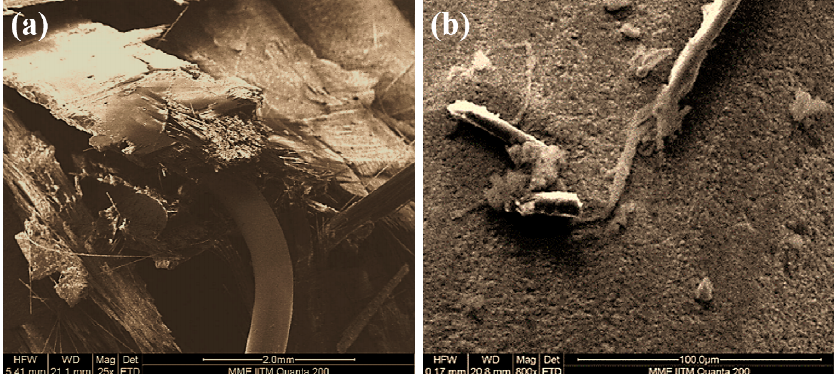
Figure 7. SEM micrograph of ( a ) SMA/matrix debonding failure mode, ( b ) interaction of SMA wire with GFRP and matrix, after impact.